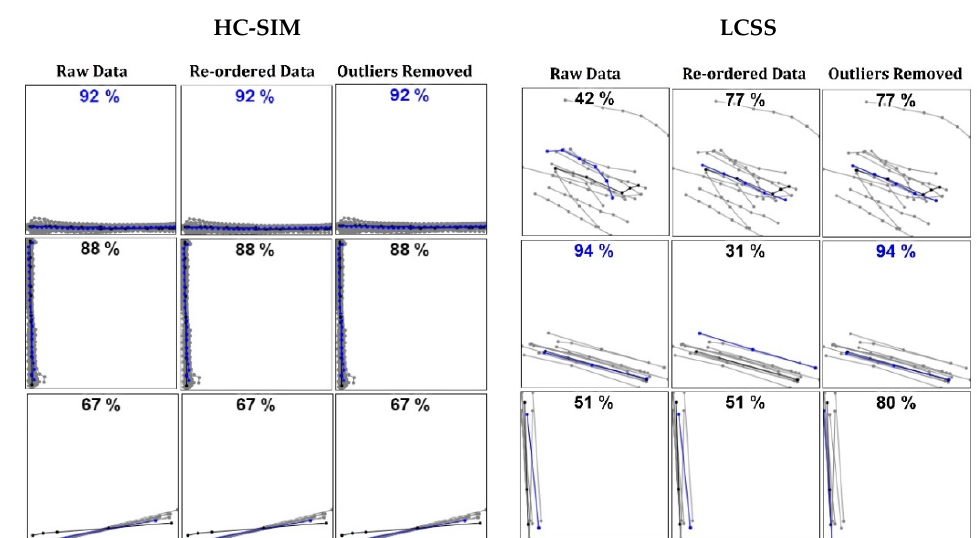
Figure 9. Examples of sets of k trajectories (gray lines) averaged by medoid with DTW distance (blue line). Black line is the ground truth.